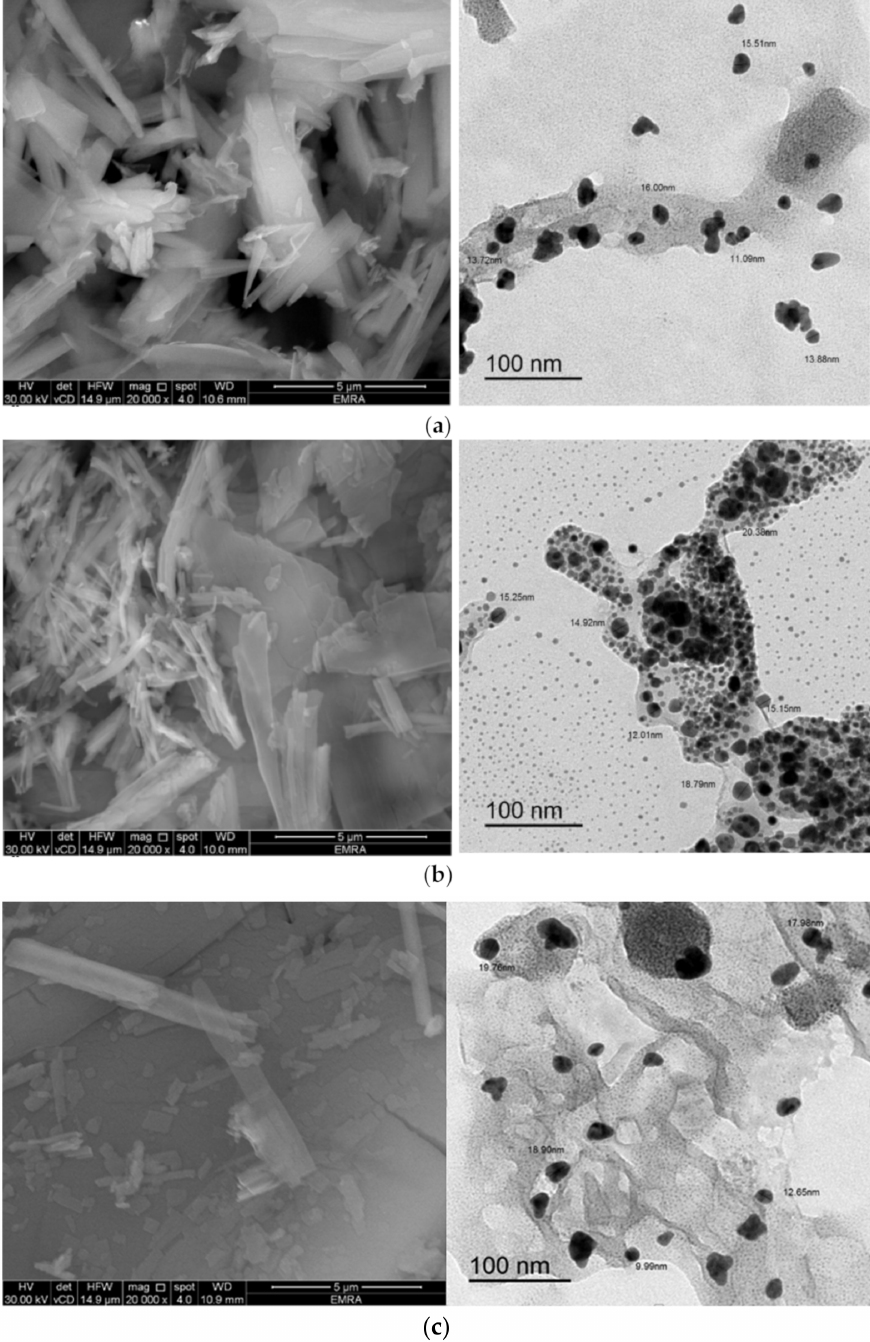
Figure 15. SEM and TEM micrographs of the ( a ) Zn 2+ complex, ( b ) Cd 2+ complex, and ( c ) Hg 2+